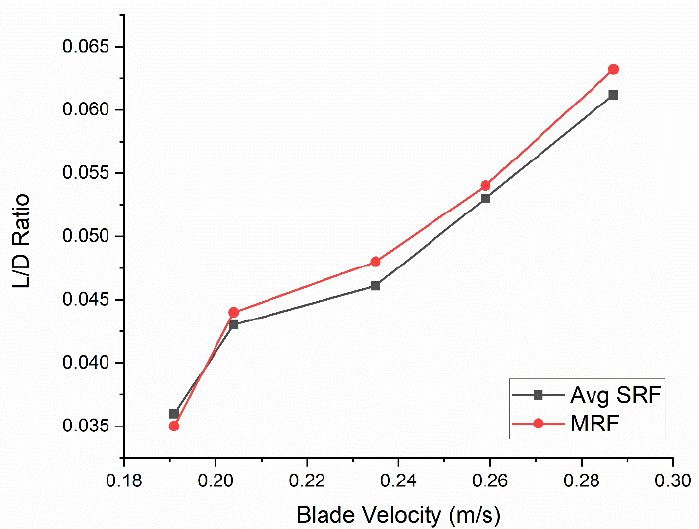
Figure 12. L/D ratio deduced from the SRF and MRF approaches.